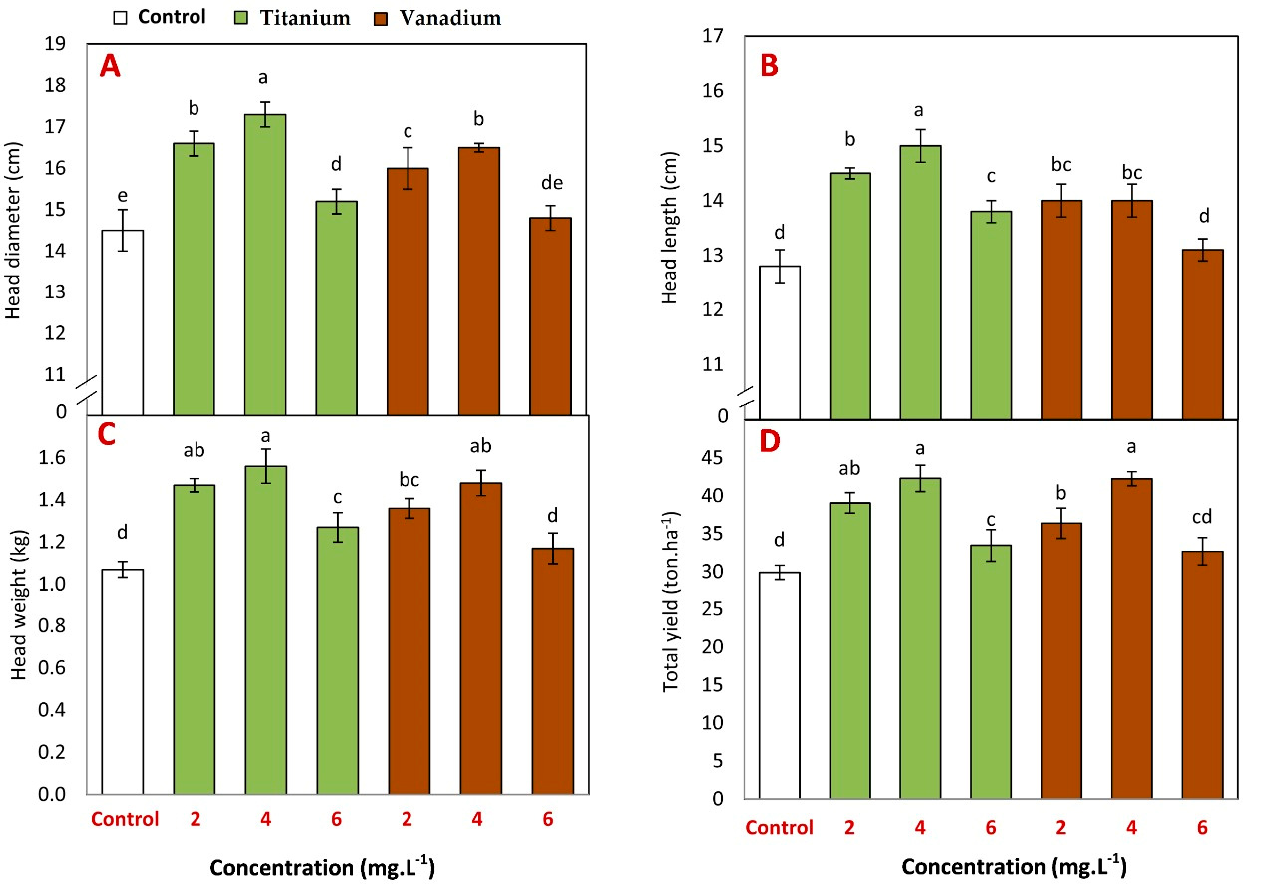
Figure 6. Head diameter ( A ); head length ( B ); head weight ( C ); and total yield ( D ) of red cabbage as affected by foliar applications with Ti and V. The mean values followed by a different letter are significantly different at p < 0.05 according to the Duncan test ( n = 3).